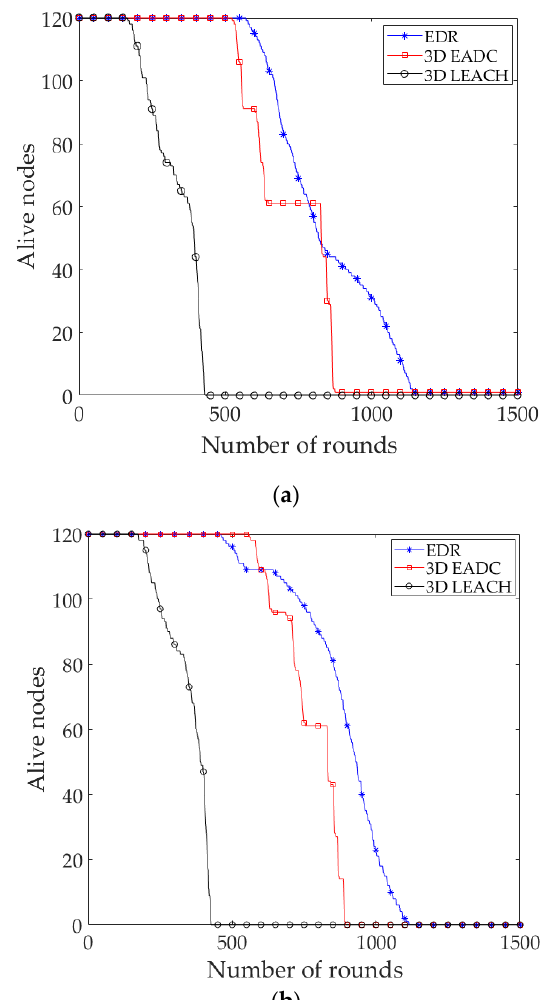
Figure 8. ( a ) Number of alive nodes in each round (uniform); ( b ) Number of alive nodes in each round (a best case of nonuniform node distribution where α = 4 and the nodes are not equally distributed over the